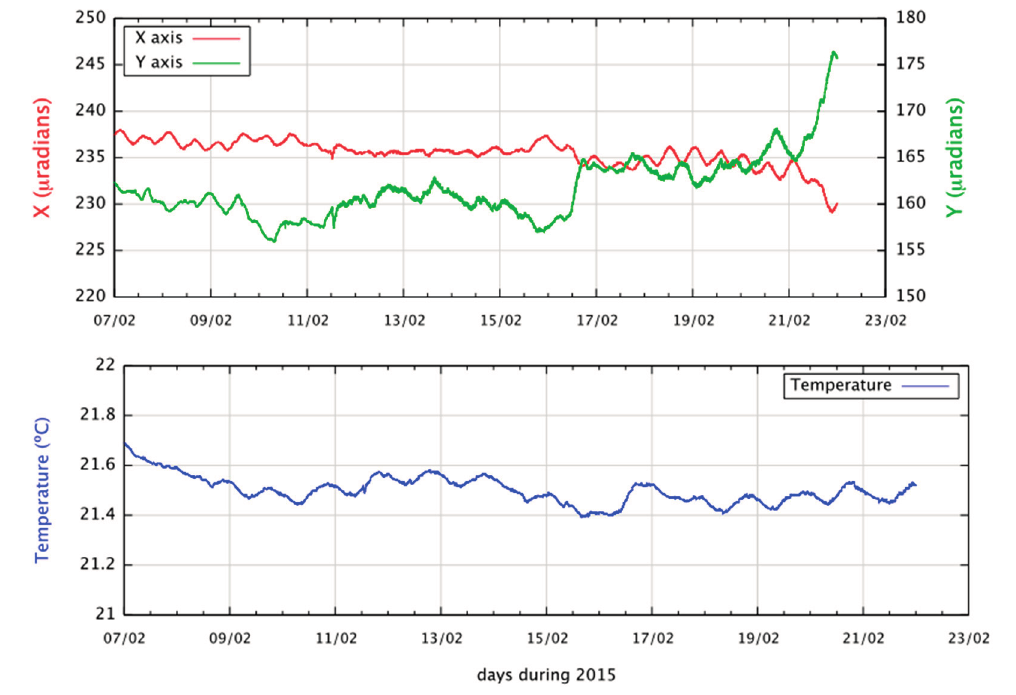
Figure 13. Fifteen days of data from the ITIG station on El Hierro. The upper graph represents the ground deformation observed for two perpendicular axes in µRad. The bottom graph shows the temperature in degrees